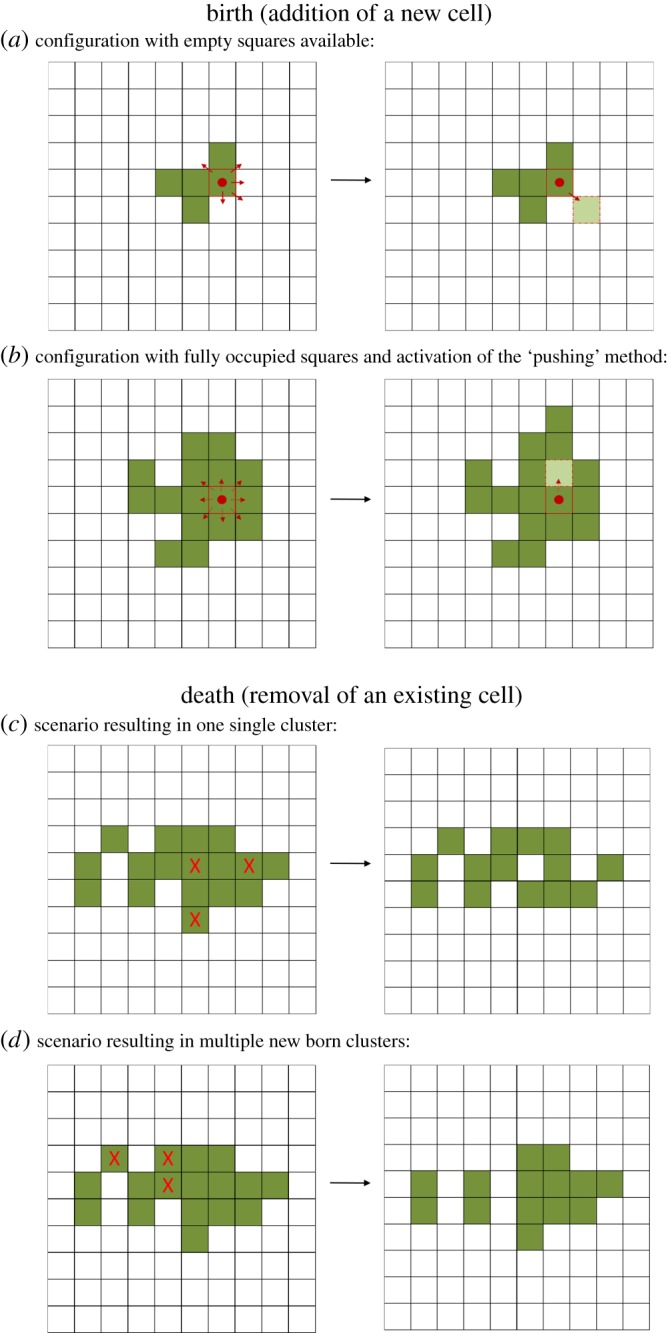
Schematic view representing cluster growth and breakage. (a,b) Birth: addition of a new cell to the cluster, where the daughter cell is placed next to the mother cell, simulating an incomplete cell division. (a) If there are free squares surrounding the mother cell, one of them will be chosen randomly to place the new cell. (b) If there are no free squares next to the mother cell, one of the eight squares surrounding the mother cell will be chosen randomly and the daughter cell will be positioned on this square, shifting the previous occupant of the square as well as all the cells adjacent to it. (c,d) Removal of cells owing to death can result in cluster breakage, depending on whether the positions occupied by the dead cells represented the only link among two or more cluster sections.